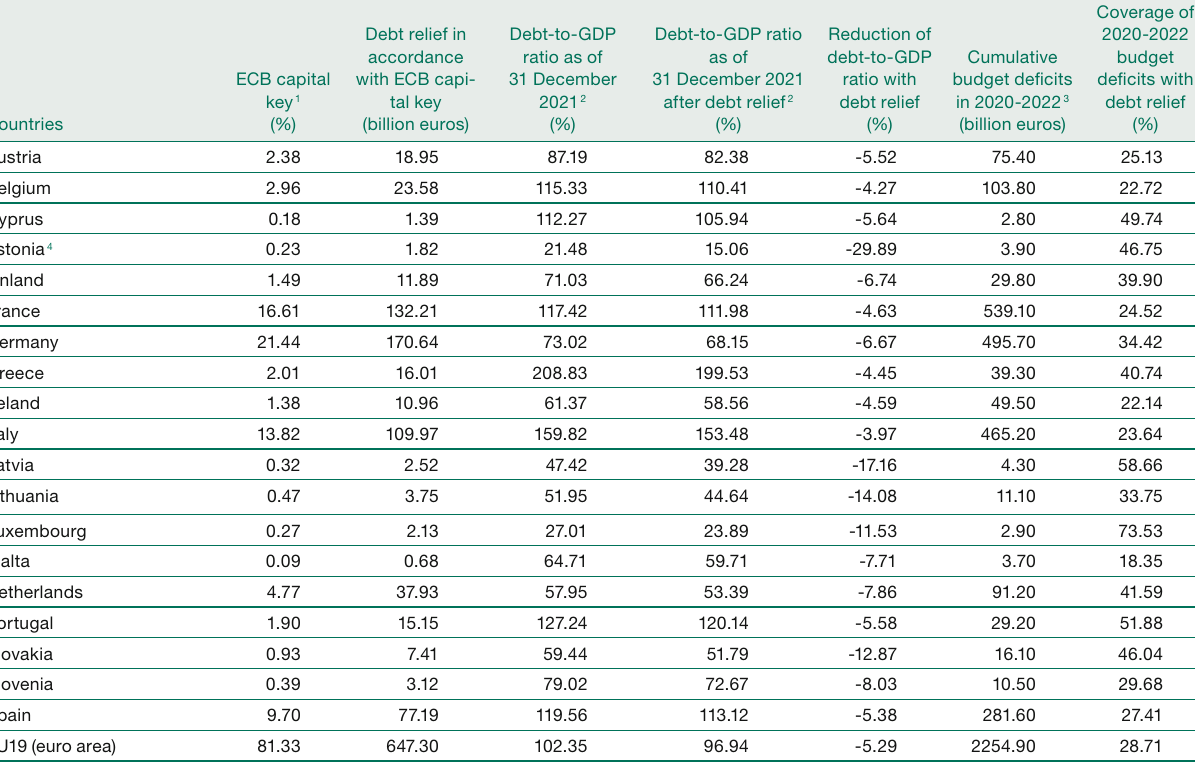
Effects of debt relief of €795.906 billion as per ECB capital key (forecasts as of 12 May